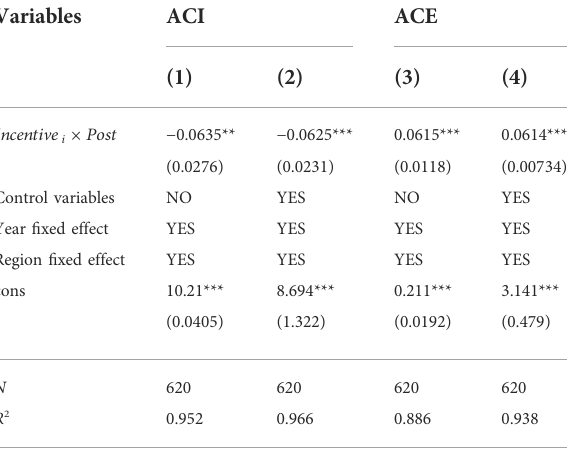
TABLE 2 Baseline regression